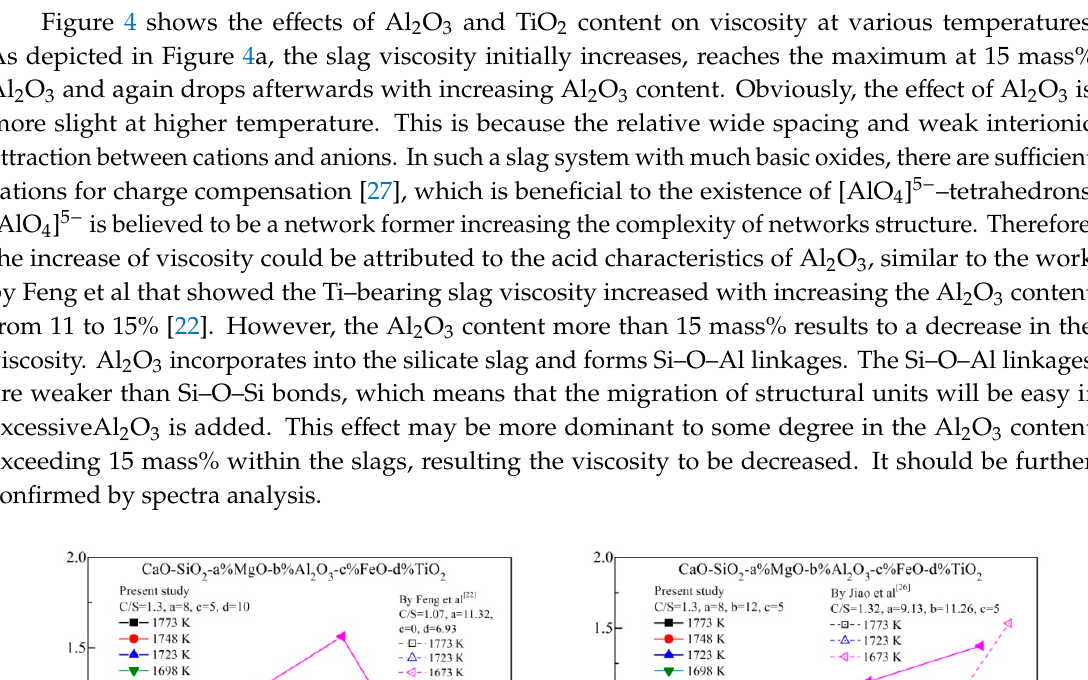
( b ) Figure 5. Natural logarithm of viscosity against reciprocal of temperature ( a ) differentAl 2 O 3 content ( b ) different TiO 2 content. Table 2. Viscosity activation energy of slags. No.